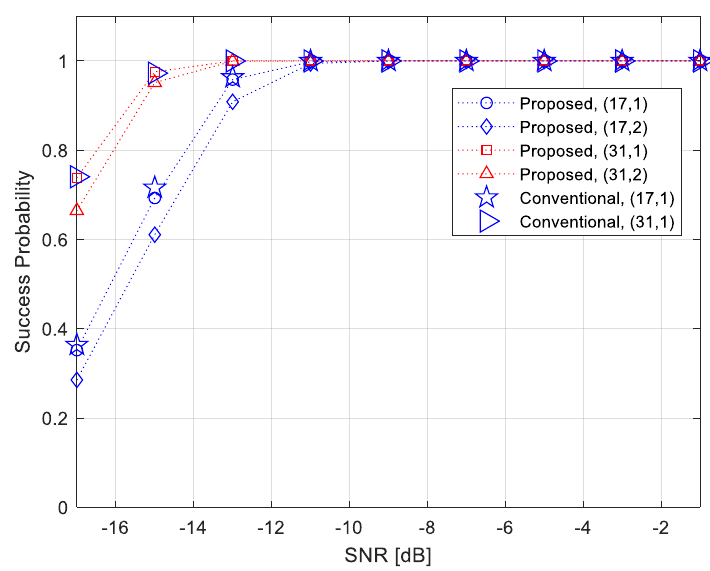
Figure 3. The performance of CID detection when the conventional and proposed methods are used (3 BSs, Rician, K = 15 dB, 1 RF).